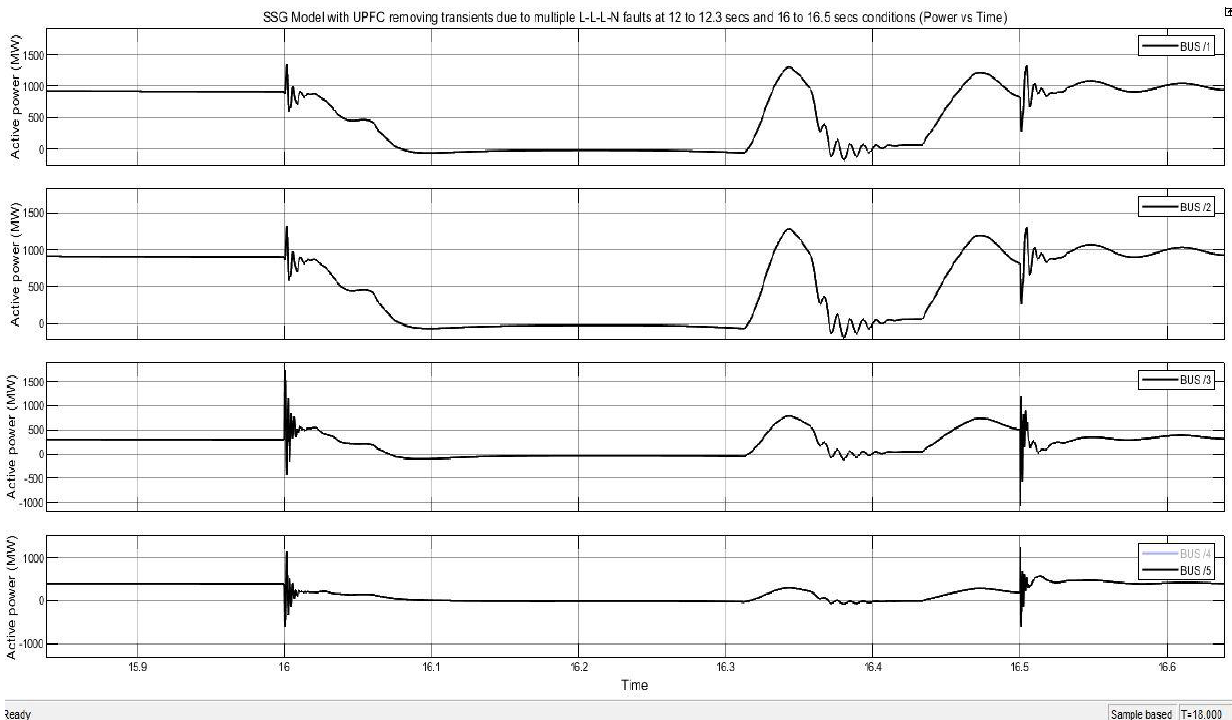
Figure 36. Transient stability being provided by UPFC after multiple L-L-L faults are introduced at 16 to 16.5 s (Bus 1 to Bus 5).